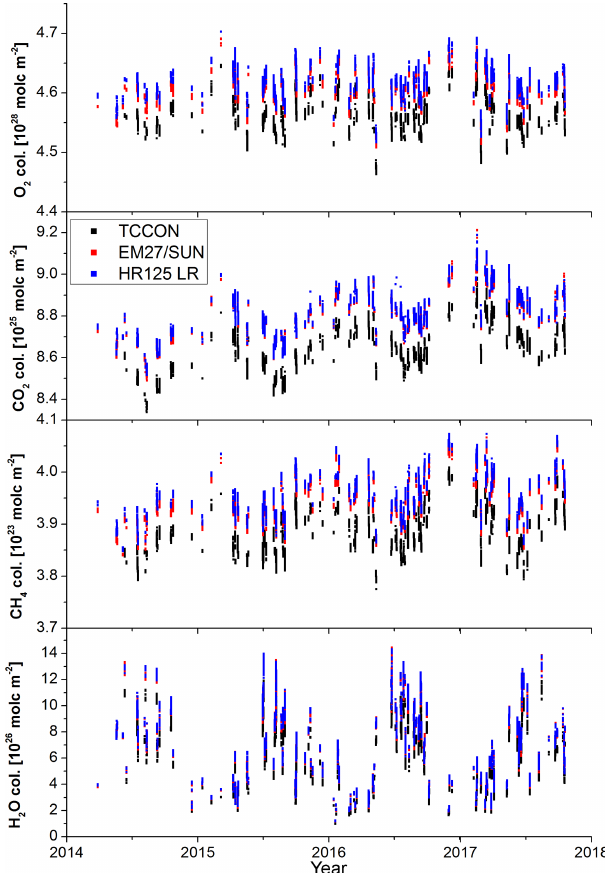
Figure 2. Total column time series for O 2 , CO 2 , CH 4 and H 2 O measured at KIT in Karlsruhe from March 2014 until October 2017. The number of interferograms and recording time for the different data types are the following: TCCON: 2 IFGs, 114s; EM27/SUN: 10 IFGs, 58s; HR125 LR: 4 IFGs, 152s. Only coincident measure- ment points (within 1min) are